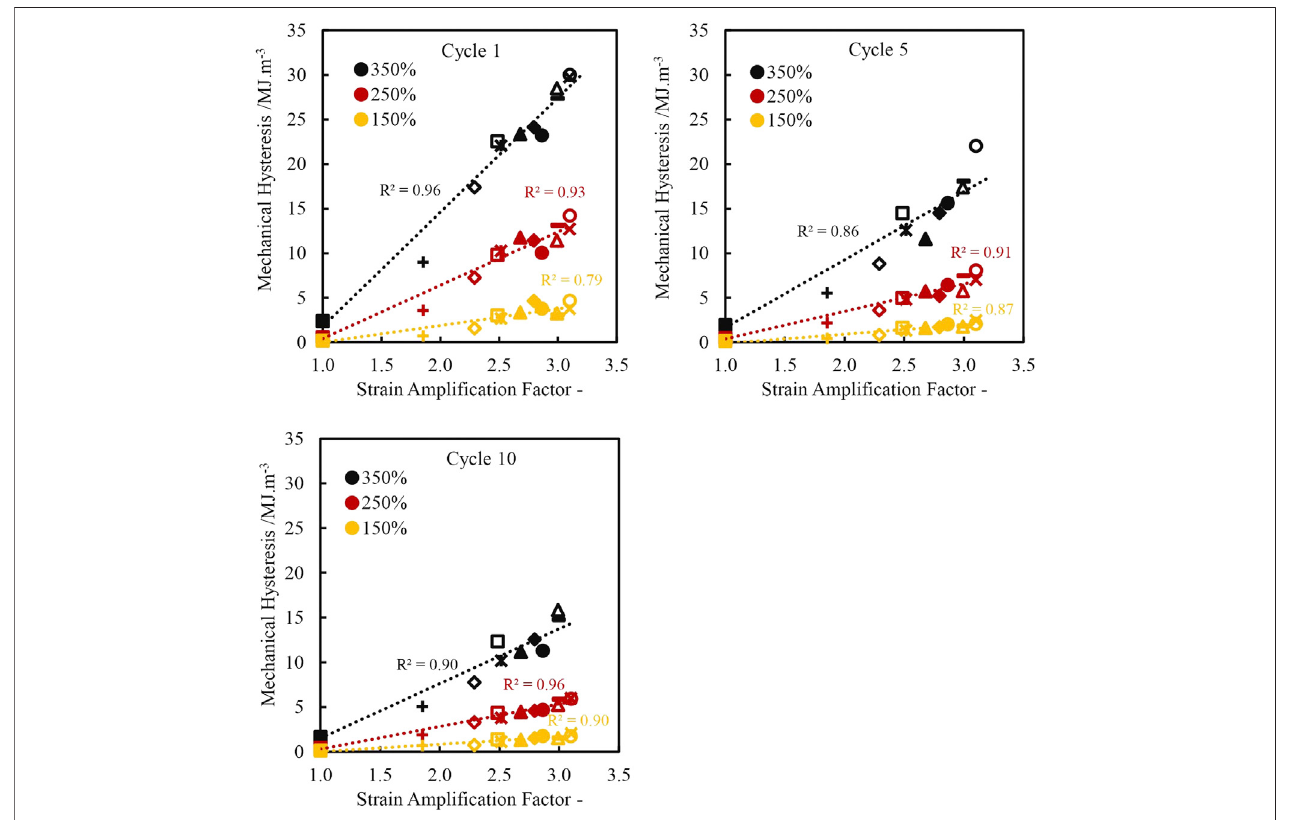
FIGURE 5 | Mechanical hysteresis on cycles 1, 5 and 10 as a function of strain ampli fi cation factor of natural rubber samples extended to 350% strain.